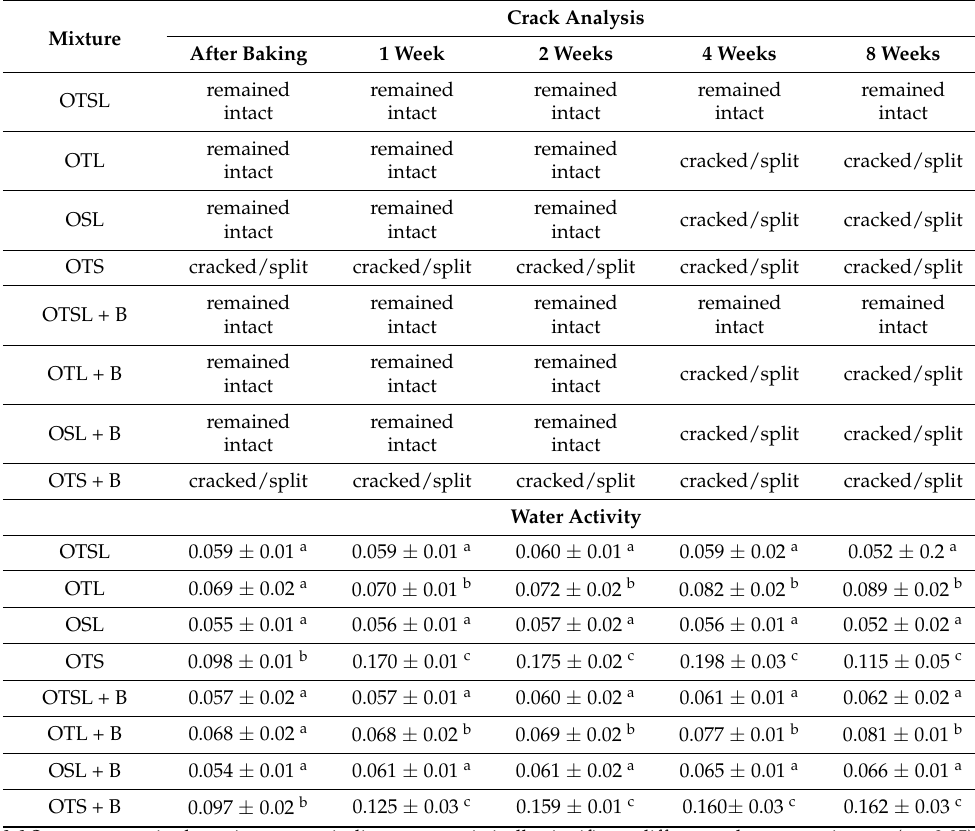
remained intact